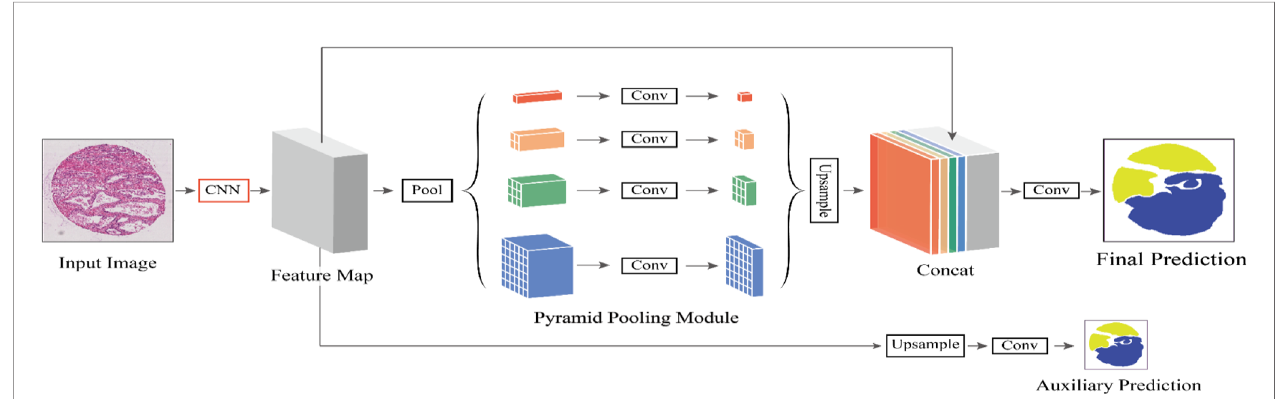
FIGURE 2 | The fl owchart of our proposed method. We de fi ne CNN as the basic feature extraction layer of our proposed network. By giving the original image, we fi rst obtain the feature mapping of the last network convolution layer using CNN and then make an auxiliary prediction for the feature mapping by upsampling and concatenation layers. Next, we obtain the fi nal feature representation with local and global information through different subregion representations in the PPM after upsampling and connection layers. Finally, these representations are fed into a convolution layer to get the fi nal per-pixel